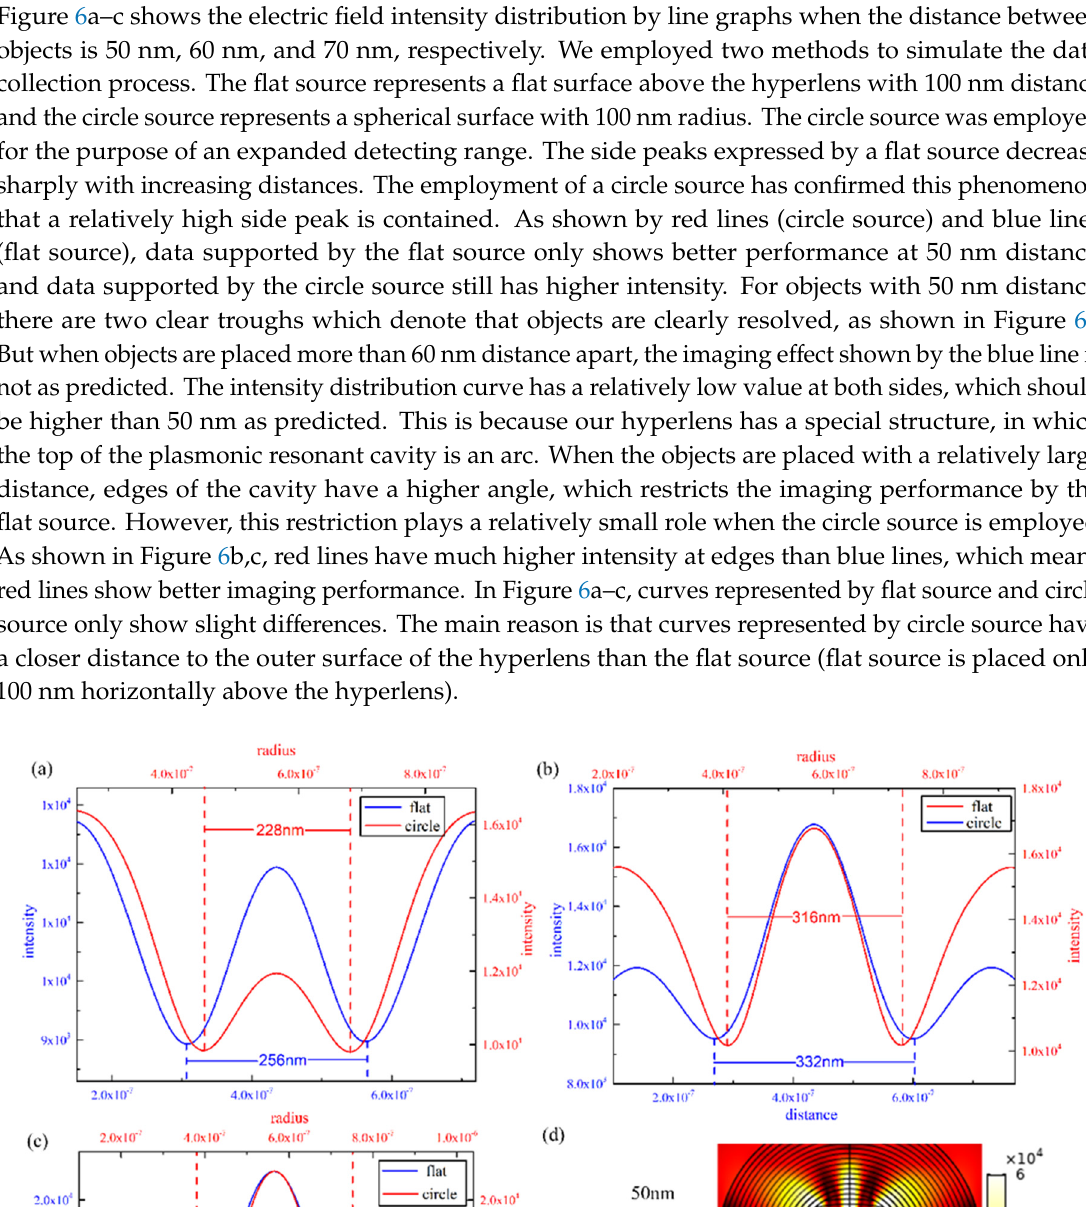
Figure 5. ( a ), ( b ) and ( c ) Electric field intensity distribution with 100 nm distance above the hyperlens expressed by line graphs. The center-to-center distance between slits is 60 nm ( a ), 70 nm ( b ), and 80 nm ( c ), respectively. ( d ) Electric field intensity distribution in the hyperlens with different center-to-center distances between the objects.